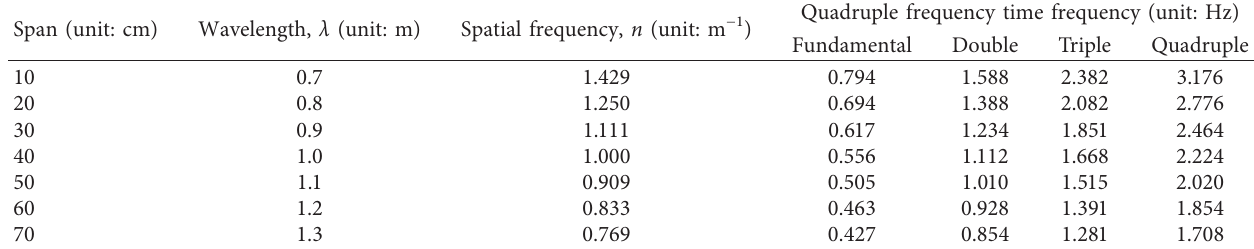
Table 3: Statistics of calculation results of excitation point wavelength, spatial frequency, and quadruple frequency of original pavement roughness signal.